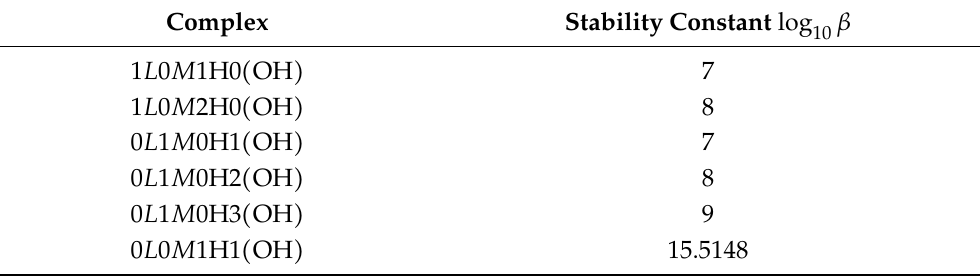
Table 3. Decadic logarithms of stability constants for the reduced reaction